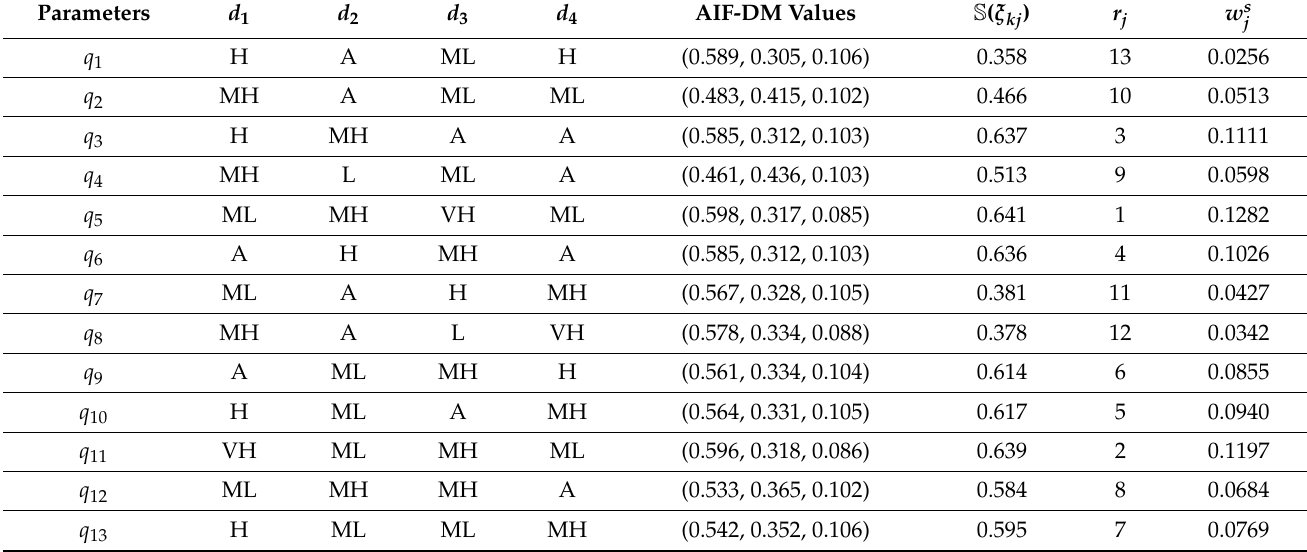
Table A5. Subjective weight of indicator using RS method for prioritizing the BESSs.